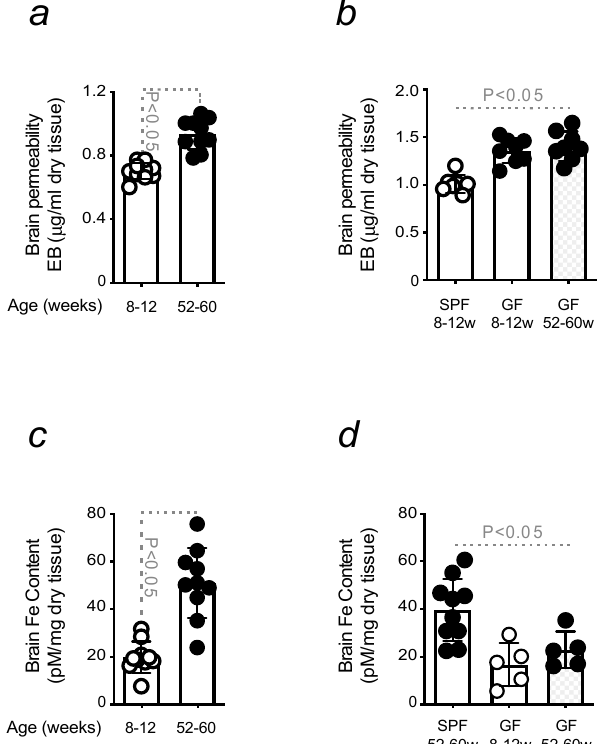
Figure 5. Increased brain permeability in old mice. ( a ) BBB permeability in young vs. old mice and ( b ) in GF animals colonized with stool from conventional old mice. ( c ) Brain Fe content was measured in ( a , d ) as in ( b ). The results were expressed as mean ± SD ( n = 5–14 mice per group). Statistical analysis was performed by applying a parametric one-way ANOVA Test.